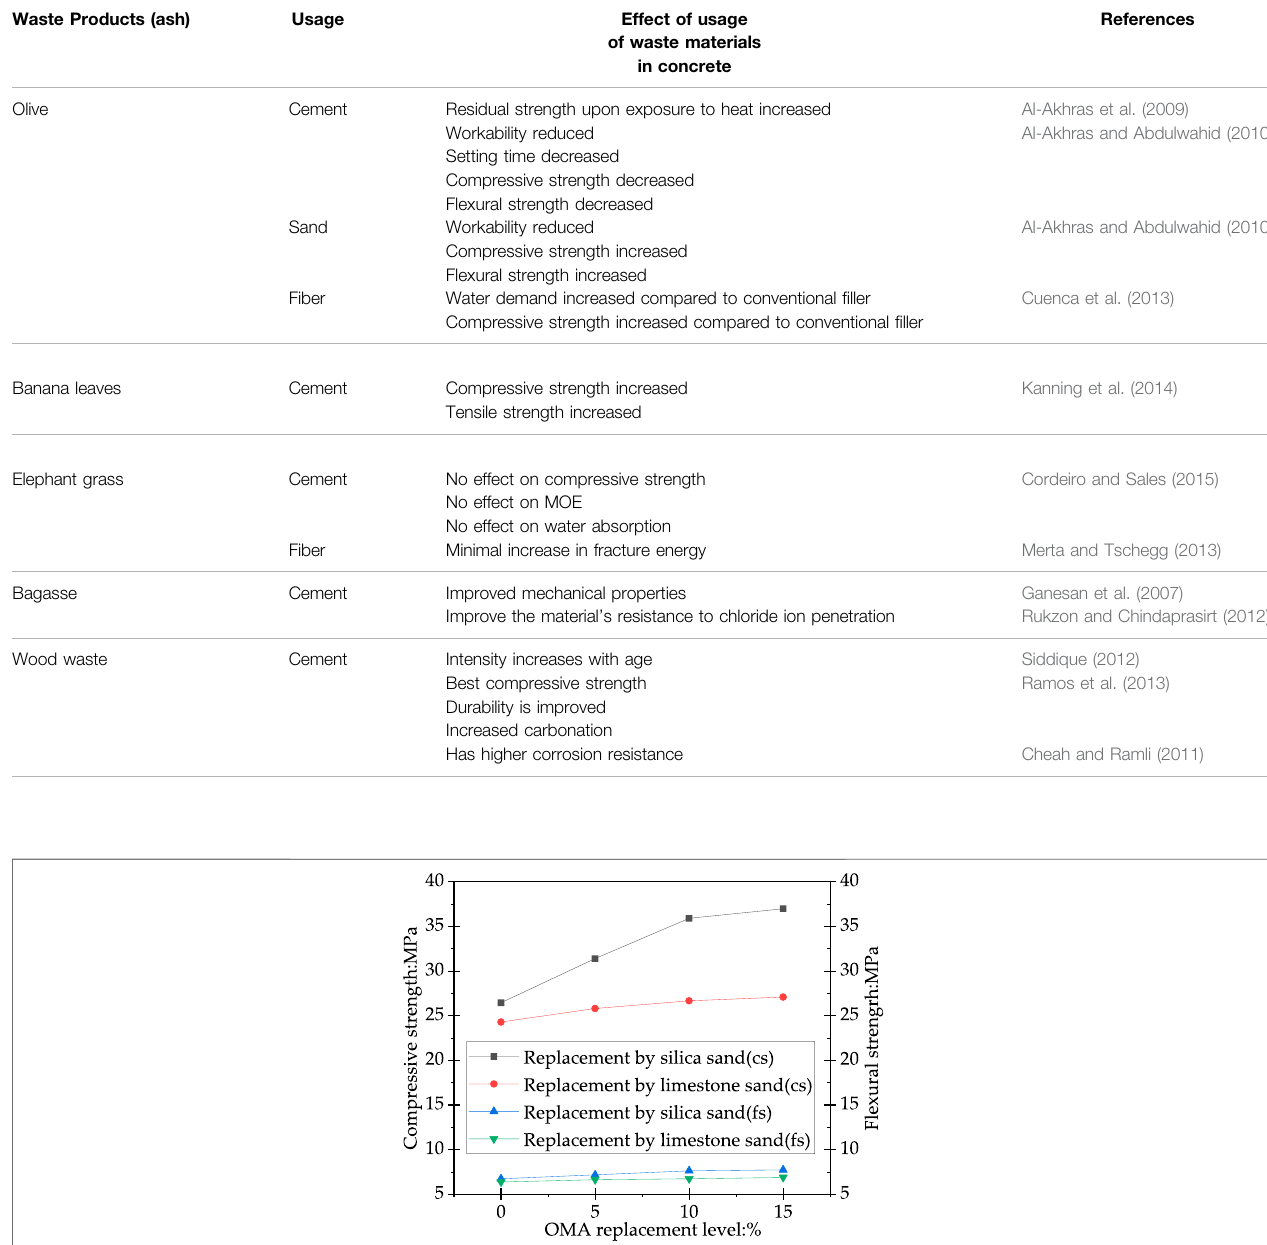
Frontiers in Materials |